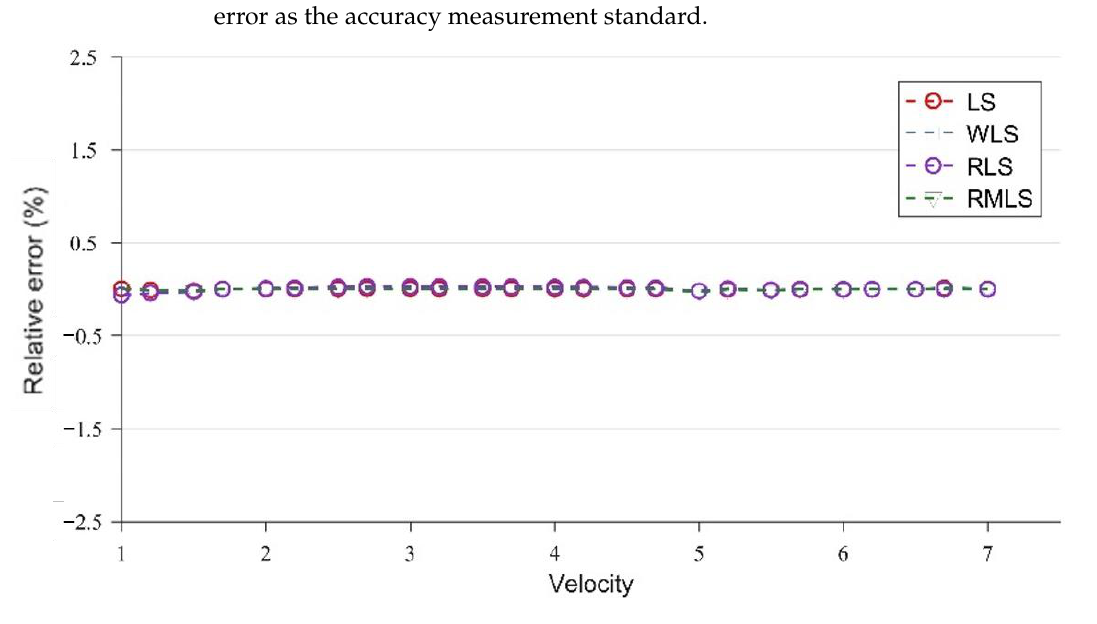
Figure 7. Results of LS, WLS, RLS, and RMLS without noise at x = 15 cm.